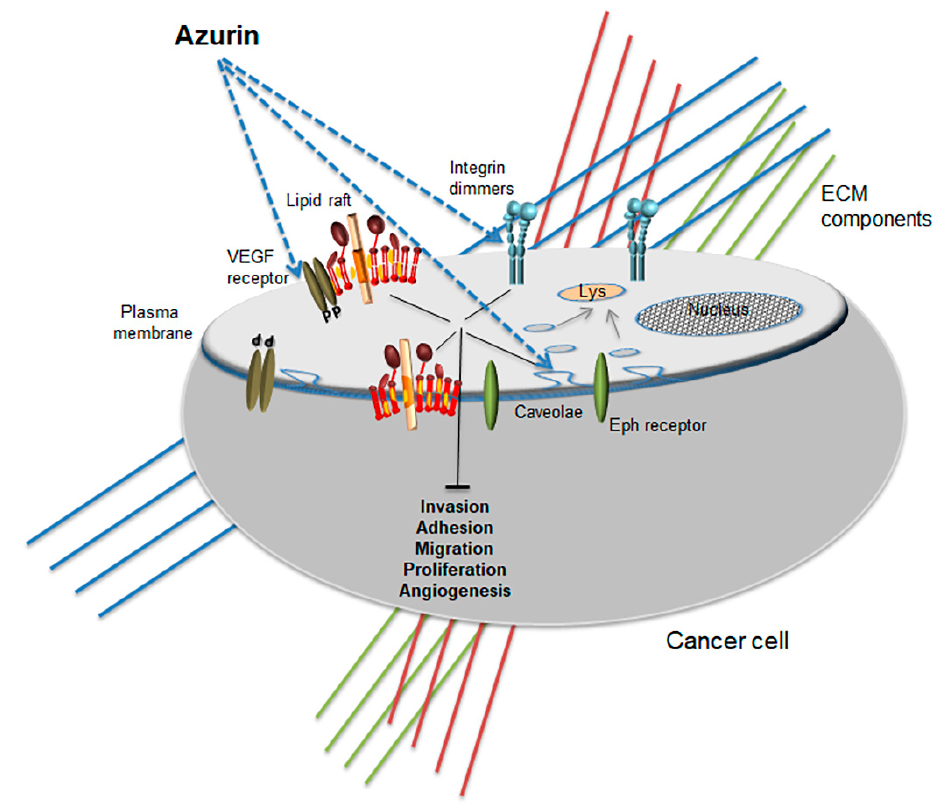
Figure 2. Promiscuous anticancer activity of azurin at the membrane level. Different membrane proteins are targeted by azurin, altering the biophysical profile and attenuating raft-related signaling pathways.